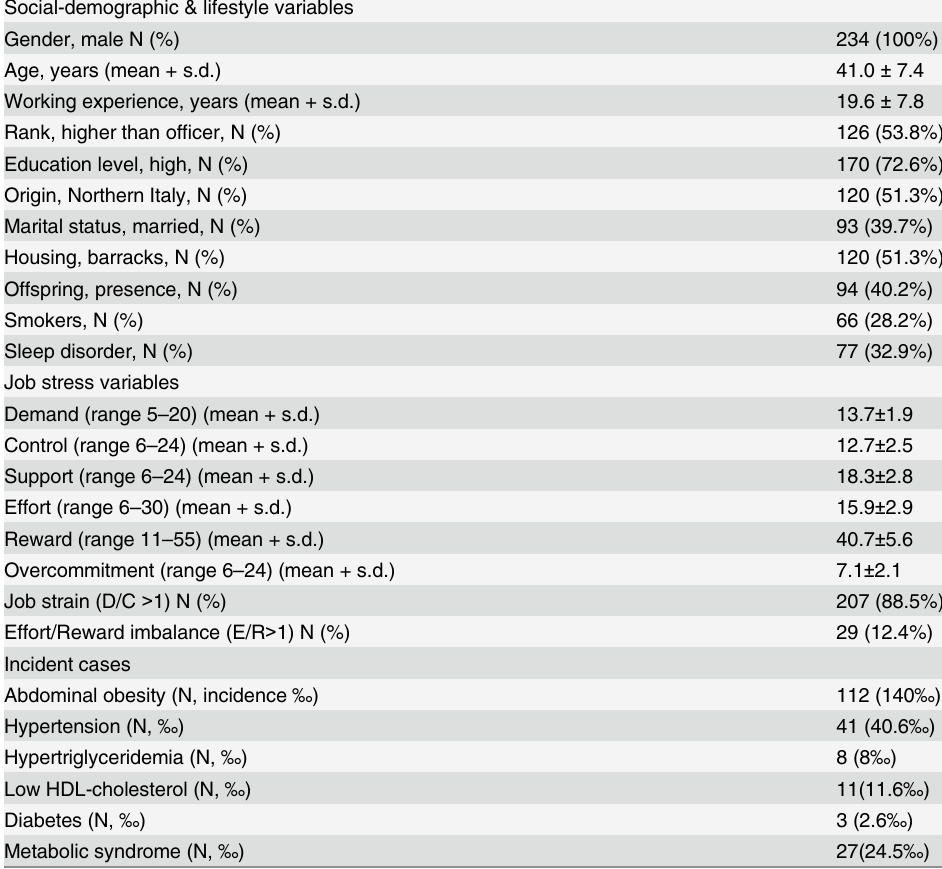
Table 1. Characteristics of the studied population at the end of the